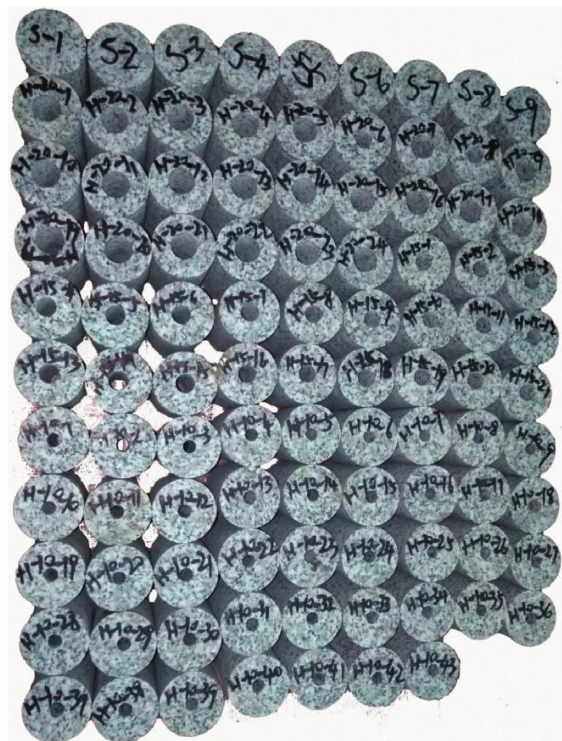
Figure 1: Thick-walled cylinder granite specimens. Table 1: Detailed information about test